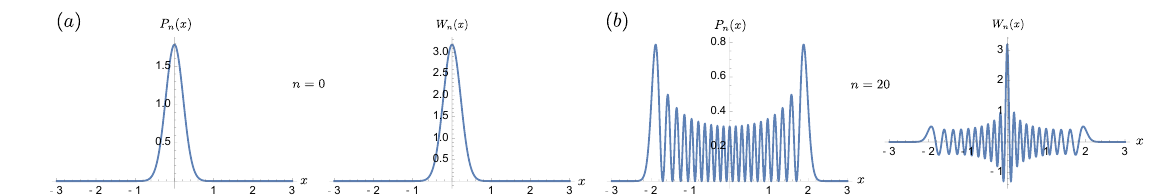
Figure 2. ( a ) shows the probability distribution P 0 ( x ) and the Wigner function W 0 ( x ) of the ground state of a harmonic oscillator. Both are positive definite. ( b ) For the excited state n = 20. It is clearly seen that the Wigner function becomes indefinite in sign. The Wigner function is evaluated at p =